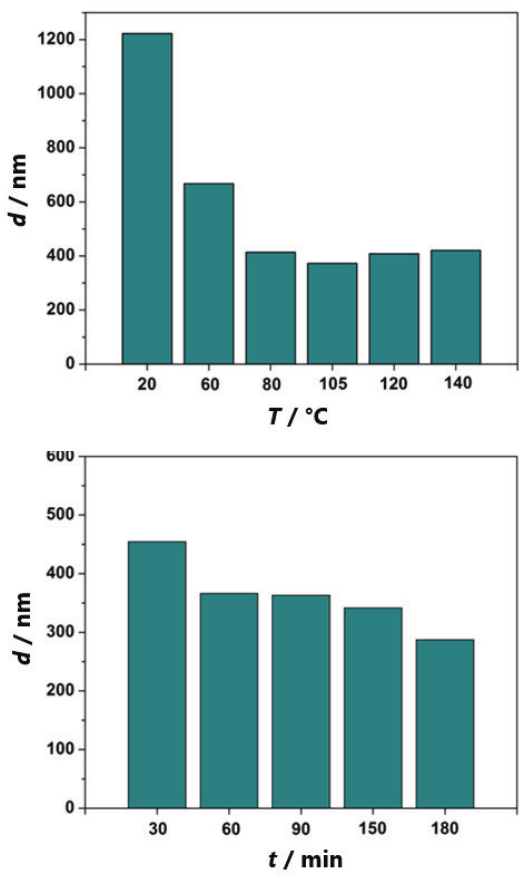
Fig. 7 – Cross-sectional SEM image of printed PMA-AgNP silver layers after sintering a) at room temperature; and b)